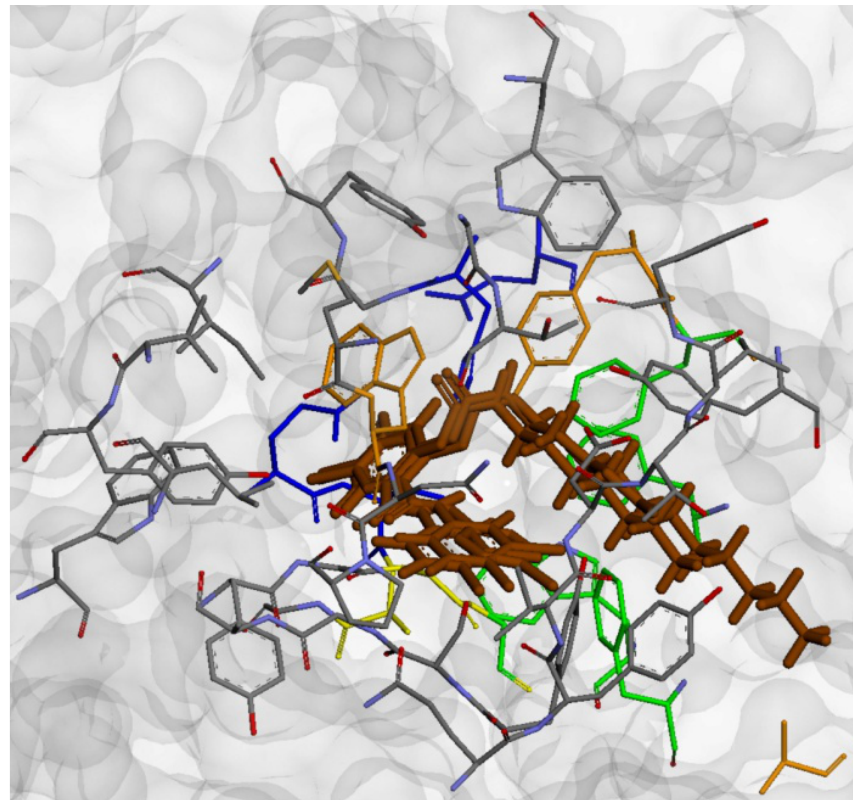
Figure 6. Graphical representation of AChE structure (solvent accessible surface, PDB ref. 2WHQ) with highlighted active site and three best ranked conformations of AChE inhibitors ( 6h , 6i and 5d , marked by brown